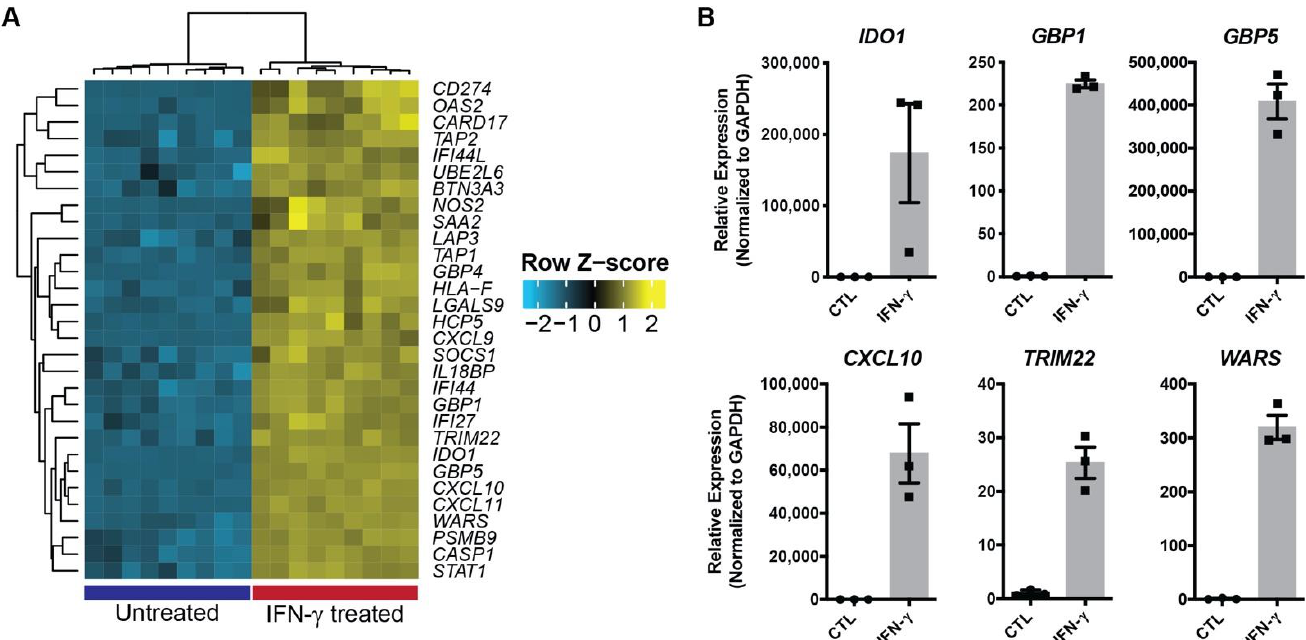
Figure 5. IFN-γ-induced gene expression changes are independent of cell line and age. ( A ) Heatmap of the top differentially expressed genes determined by microarray analysis in 70-day HIOs treated with IFN-γ and derived from iPSC line CS83iCTR-n33. ( B ) Gene expression changes of 6 selected IFN-γ-responsive genes determined by qPCR in 30-day HIOs differentiated from iPSC line (CS688iCTR-n5).